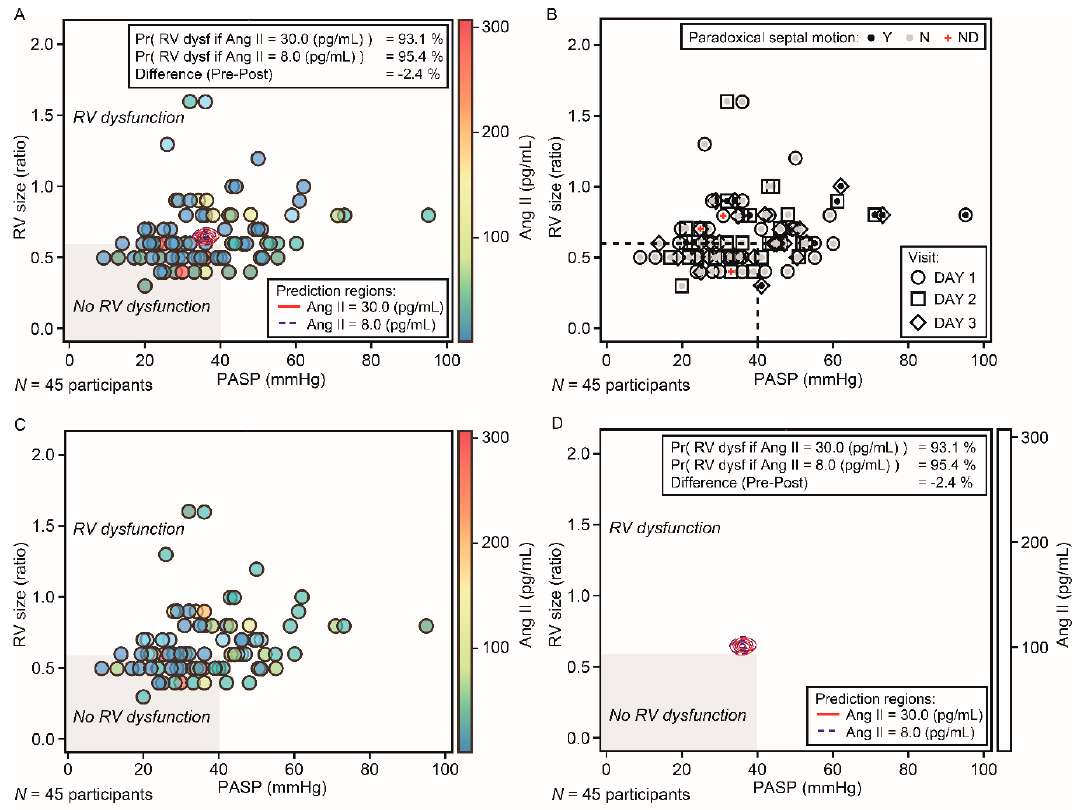
Figure 5. PCD measurements for hypothetical ‘pre-‘ and ‘post-‘dose Ang II concentrations ( A ); scatterplot of PASP versus RV size ratio, marked by interventricular septal motion status ( B ) and colored by Ang II concentration ( C ), with posterior prediction regions ( D ). Data are for ‘pre-dose’ 30 pg/mL and ‘post-dose’ 8 pg/mL Ang II concentrations. The horizontal reference lines correspond to the defined threshold value for PCD . Figure 4A contains additional sampling points that did not have an associated Ang II concentration value. Ang , angiotensin; N , no; ND , not done; PASP , pulmonary arterial systolic pressure; PCD , pulmonary circulatory dysfunction; Pr , probability; Y , yes.